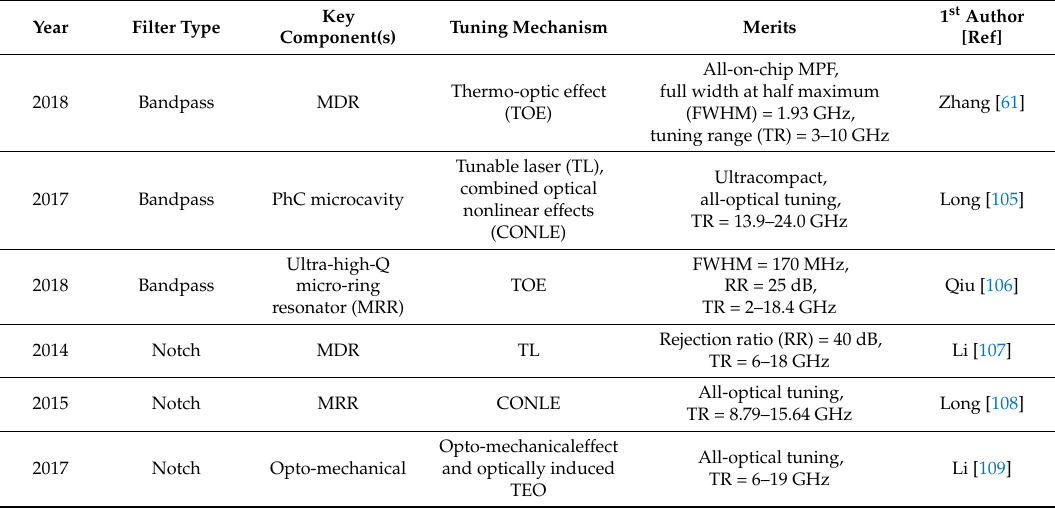
Table 1. Selected reported results for silicon-based integrated microwave photonic filter